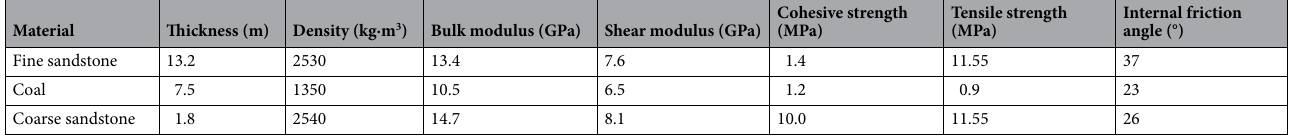
Table 2. Mechanics parameters of rock